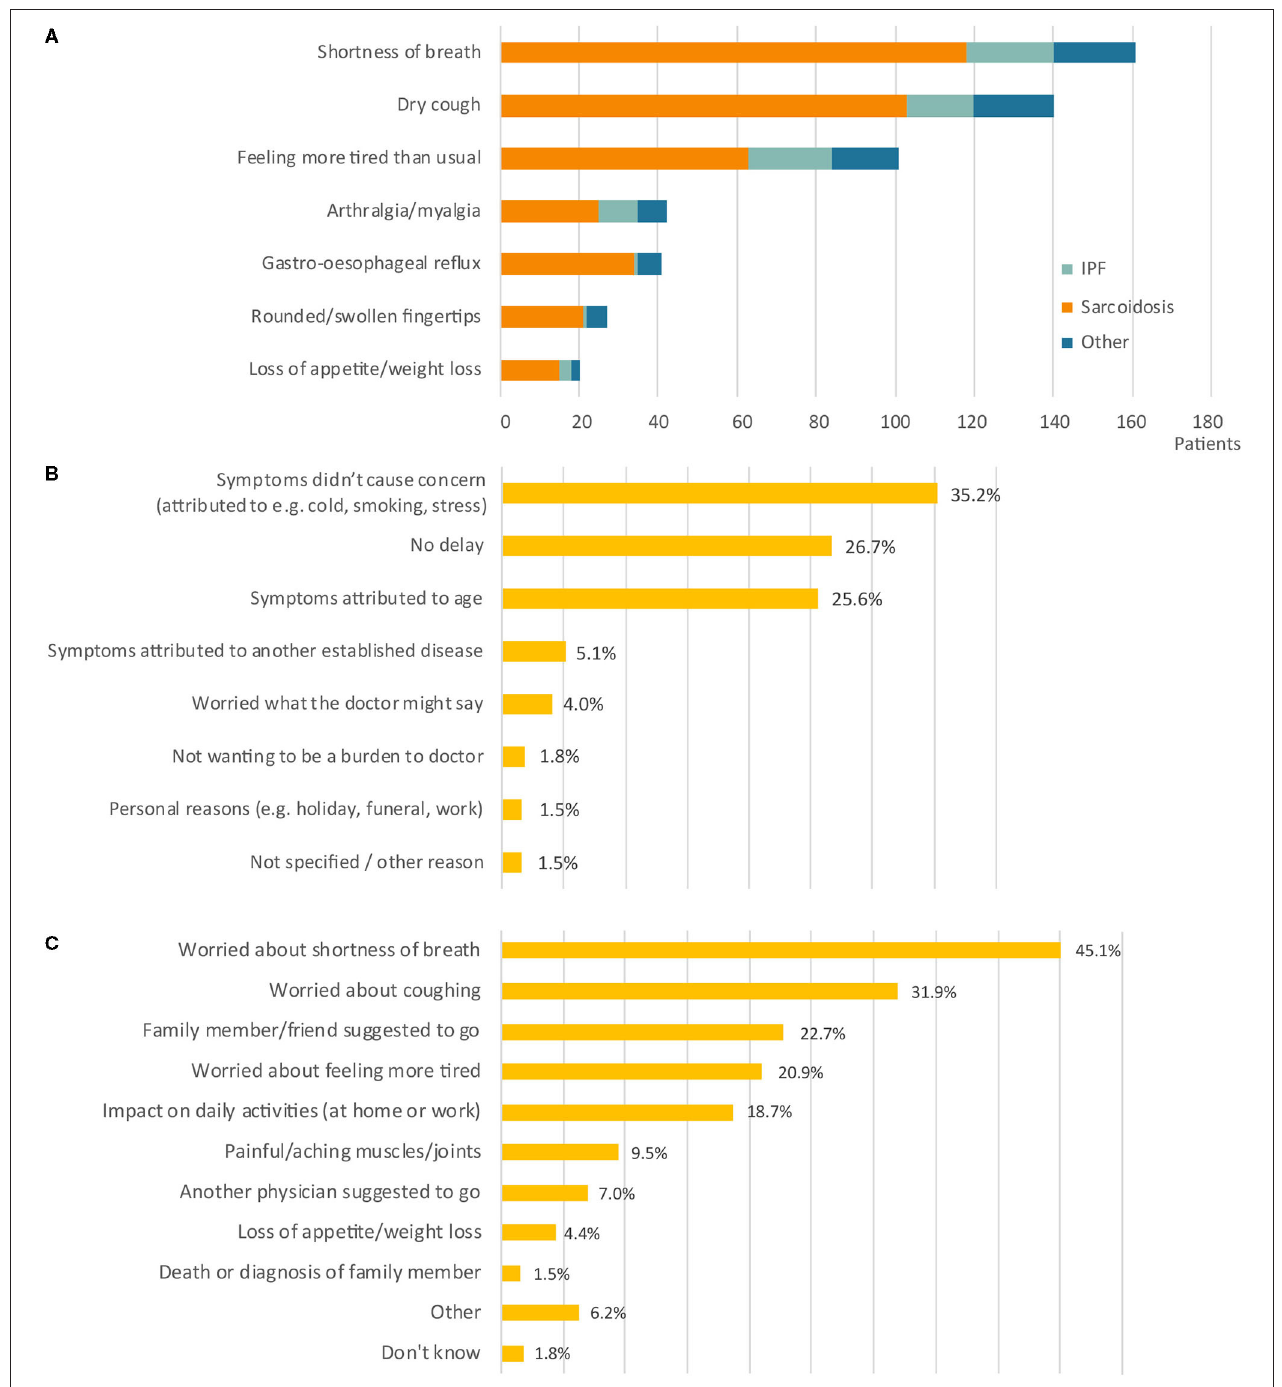
FIGURE 2 | Patient symptoms and motives in stage 1. (A) Number of patients ( n = ) reporting a specific symptom at onset. Bars are divided into diagnosis groups (total responses n = 532). (B) Reason to delay the initial primary care appointment ( n = 277). (C) Reason to schedule the initial primary care appointment ( n = 463). Percentages do not add up to 100% as more than one response was allowed. IPF, idiopathic pulmonary fibrosis.